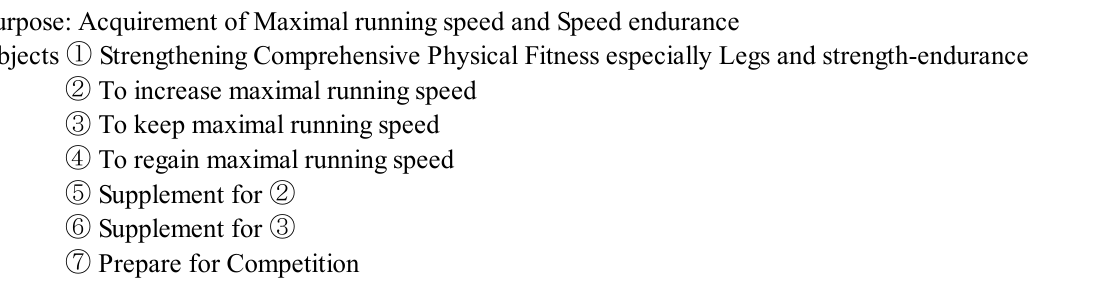
Figure 2. Concept of overall sprint training program throughout the year.